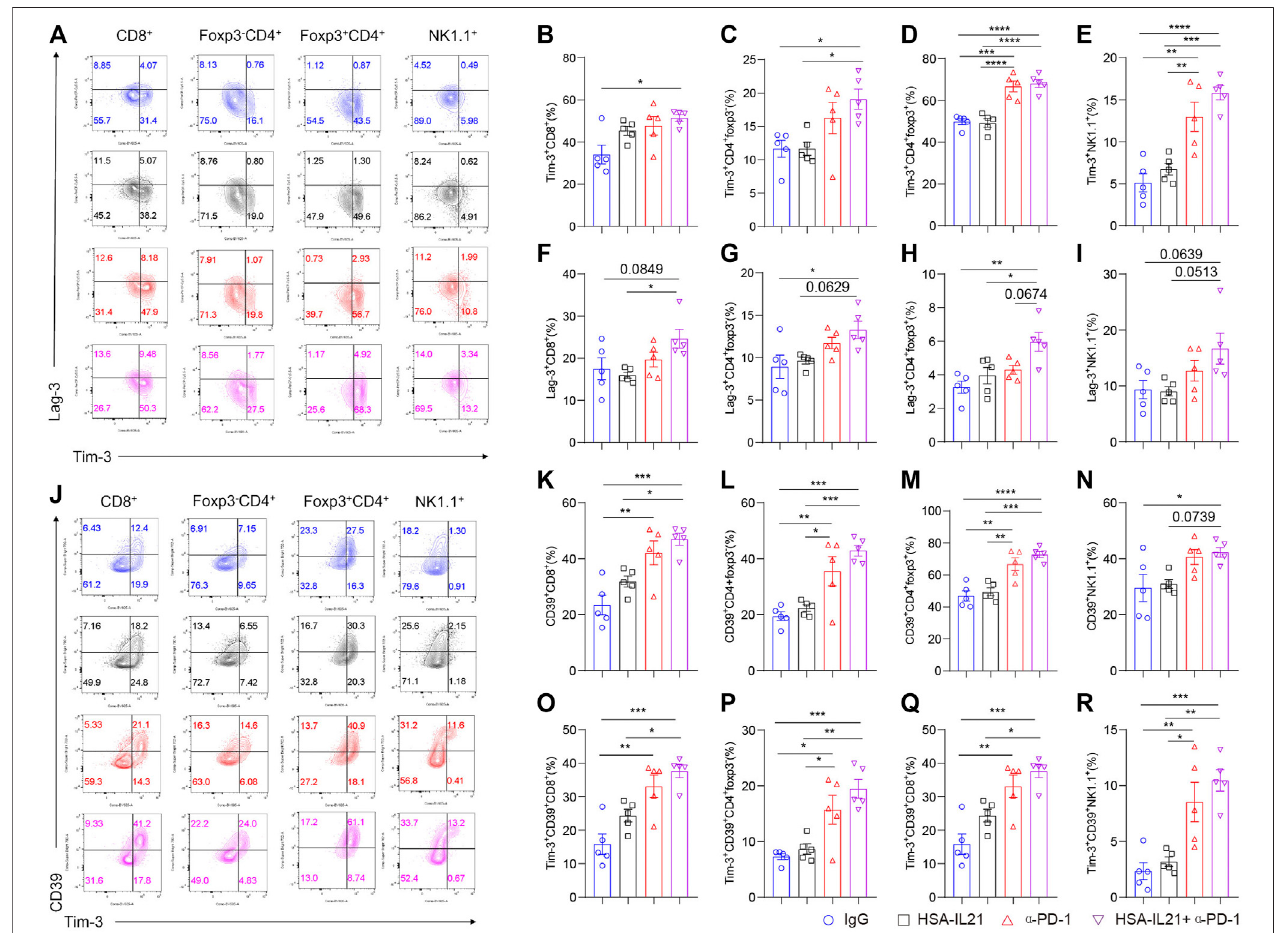
FIGURE 4 | Combination therapy induces expression of immune checkpoint molecules on tumor-in fi ltrating lymphocytes. (A – I) MC38 tumor cells (1 × 10 6 ) were injected intradermally to B6 mice, 9 days after tumor inoculation, MC38 tumor-bearing mice were treated with IgG, HSA-IL21, α -PD-1, HSA-IL21/ α -PD-1, 96 h later, tumors were resected and analyzed by fl ow cytometry. (A) Representative fl ow plots showing Tim-3 and Lag-3 staining in CD8 + , Foxp3 - CD4 + , Foxp3 + CD4 + T and NK cells. (B – I) Quantitative percentage of Tim-3 and Lag-3 expression in CD8 + , Foxp3 - CD4 + , Foxp3 + CD4 + T and NK cells. Data were presented as mean ± SEM, n (cid:2) 5, *p < 0.05, ** p < 0.01, *** p < 0.001, **** p < 0.0001, one-way ANOVA test was performed. (J) Representative fl ow plots showing Tim-3 and CD39 staining in CD8 + , Foxp3 - CD4 + , Foxp3 + CD4 + and NK cells. (K – R) Quantitative percentage of CD39 and CD39/Tim-3 double positive expression in CD8 + , Foxp3 - CD4 + , Foxp3 + CD4 + T and NK cells. Data were presented as mean ± SEM, n (cid:2) 5, *p < 0.05, ** p < 0.01, *** p < 0.001, **** p < 0.0001, one-way ANOVA test was performed.